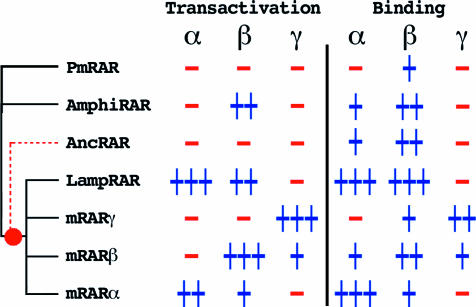
Representation of the Transactivation and Binding Capacities of the RARs Used in the Present StudyThe three synthetic retinoids are shown as α, BMS753; β, BMS641; and γ, BMS961. The phylogenetic relationships between the RARs have been schematized by a phylogenetic tree (the tunicate and amphioxus RARs have been polytomised, LampRAR is also polytomised with the vertebrate RARs). The putative position in the tree of the ancestral sequence is indicated by a dashed branch in red.